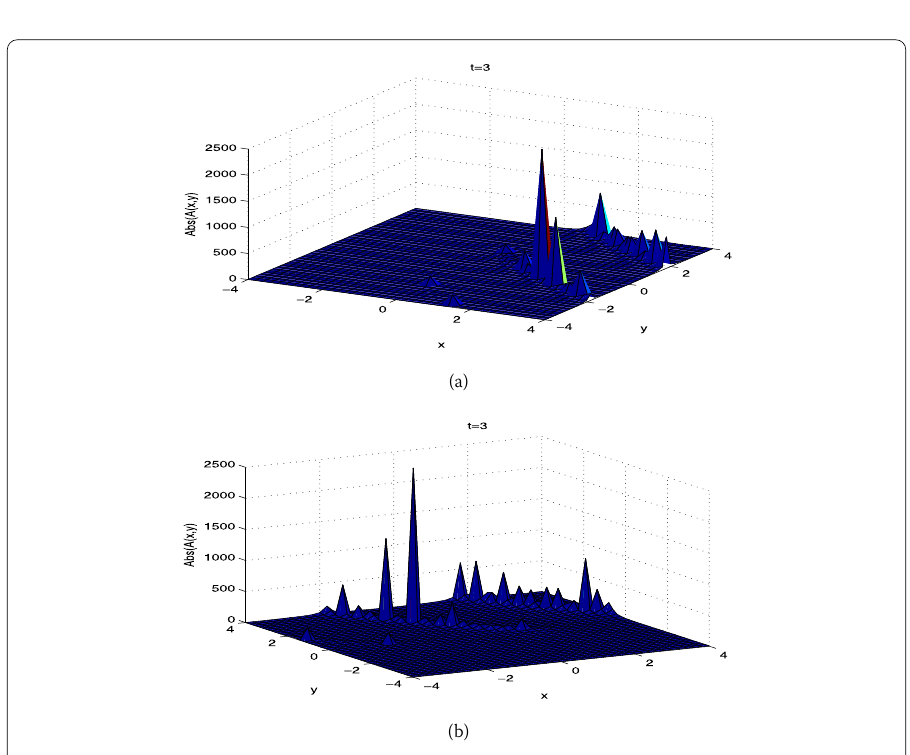
Figure 6 ( a ) The exact solution represented by Eq. (78), t = 3, α = 1, β = 0.75, γ = 1. ( b ) The exact solution represented by Eq. (78), t = 3, α = 1, β = 1, γ =